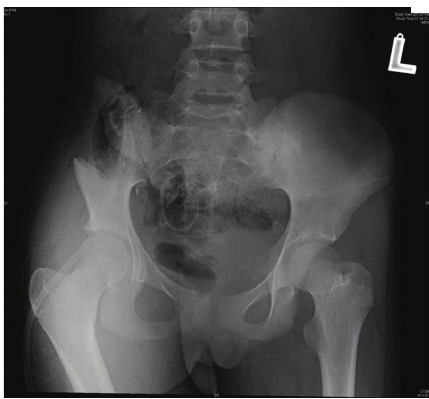
Figure 3: X-ray image of the patient showing right internal